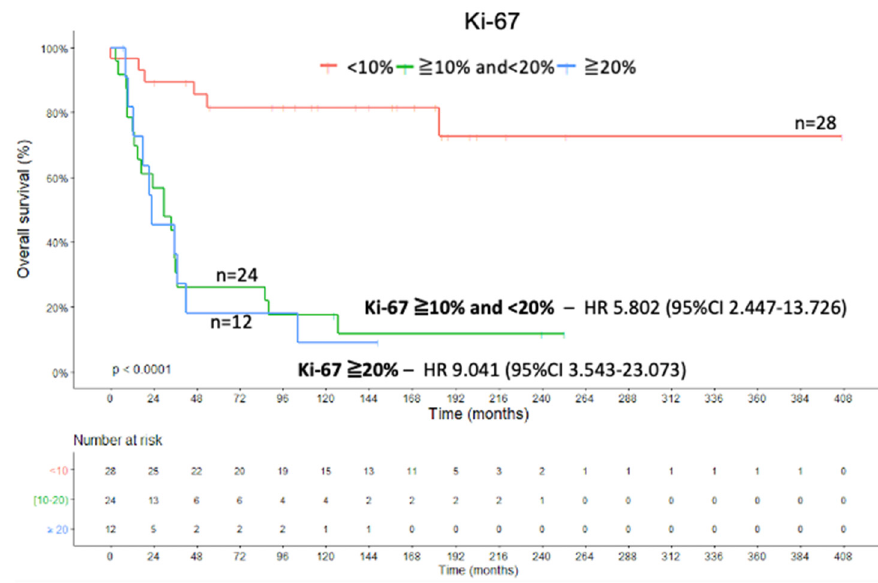
Figure 5. Ki-67 proliferation marker—OS Kaplan–Meier curve.